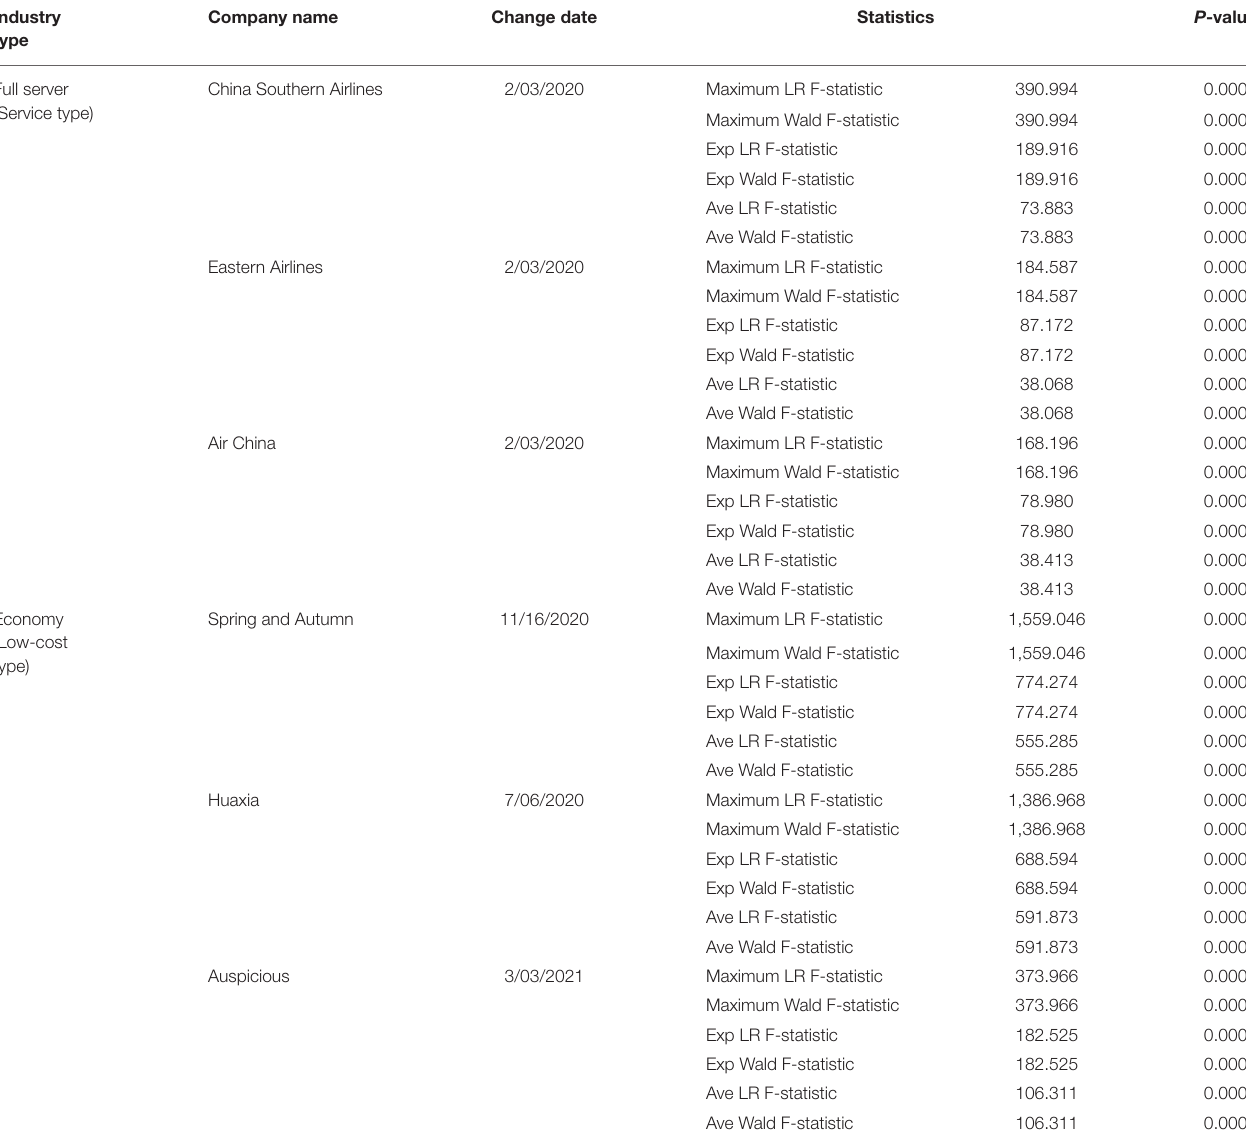
TABLE 3 | Quandt-Andrews inspection results of two types of Chinese